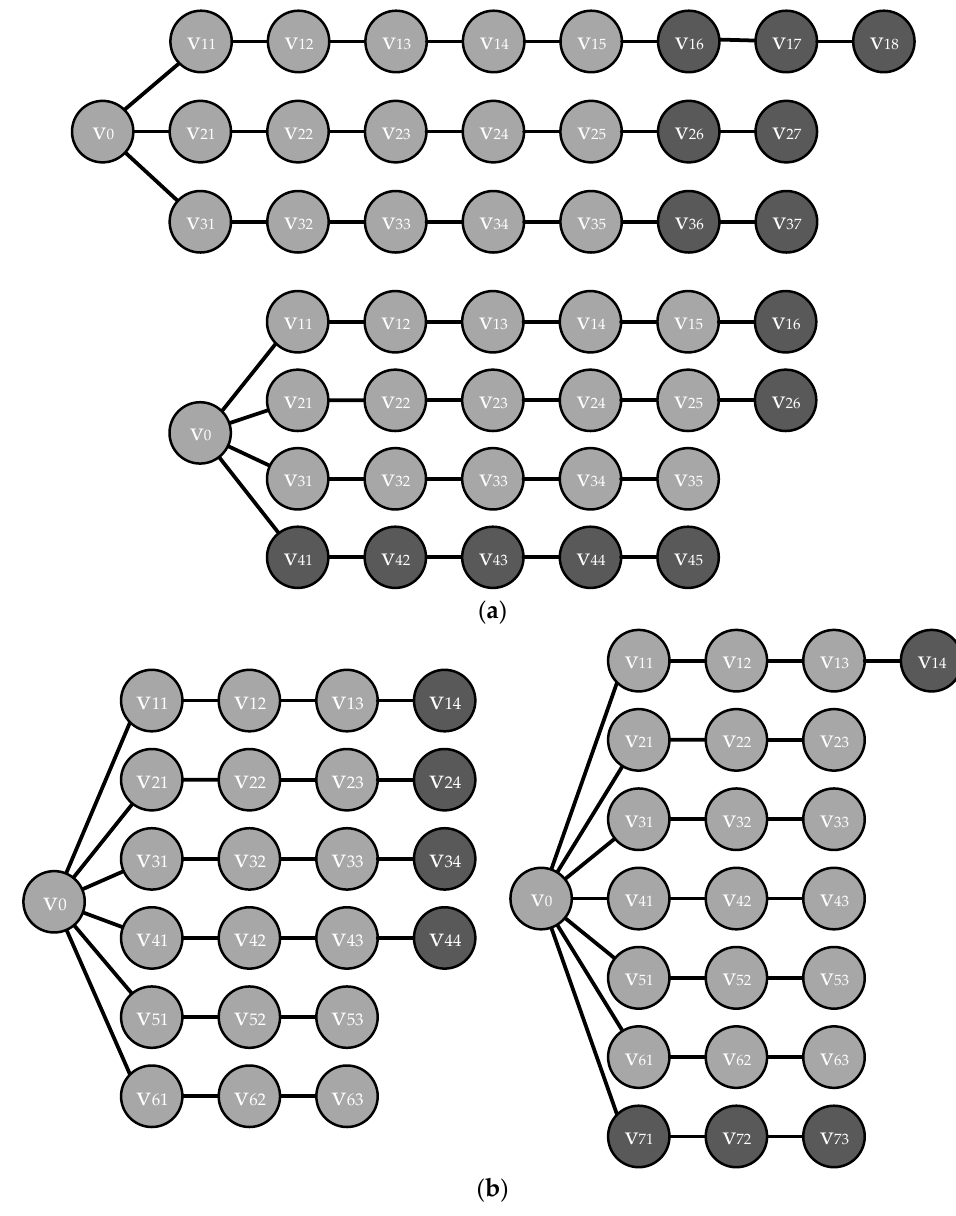
Figure 5. “ Star” type structures ( a ) with 3 and 4 rays; ( b ) with 6 and 7 rays. Figure 5. “Star” type structures ( a ) with 3 and 4 rays; ( b ) with 6 and 7